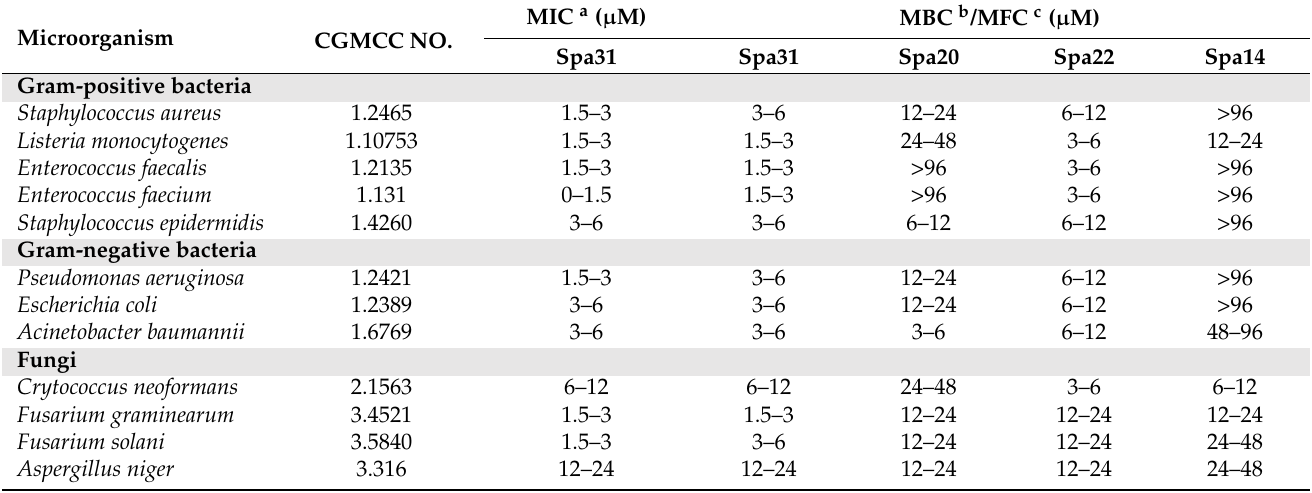
Figure 1. Basic information of the four synthetic peptides. ( A ) Peptide sequences, total net charge and hydrophobicity of Spa31, Spa20, Spa22, and Spa14. ( B ) The predicted 3D structures of Spa31, Spa20, Spa22, and Spa14 using the PepFold tool. Table 2. Antimicrobial activity of four synthetic peptides.